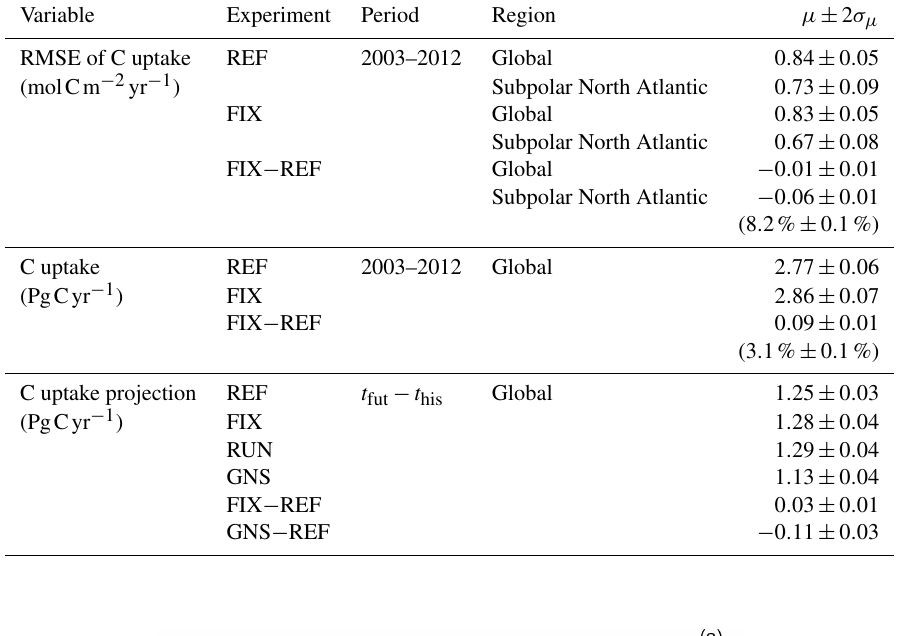
Table B2. Global and regional statistics of simulated ocean carbon uptake. Shown are the time mean µ and twice its standard deviation σ µ (rounded up to two decimals) derived from annual values. The t his and t fut denote the time periods 1950–1999 and 2050–2099, respectively. Values in brackets denote relative changes in percentage.